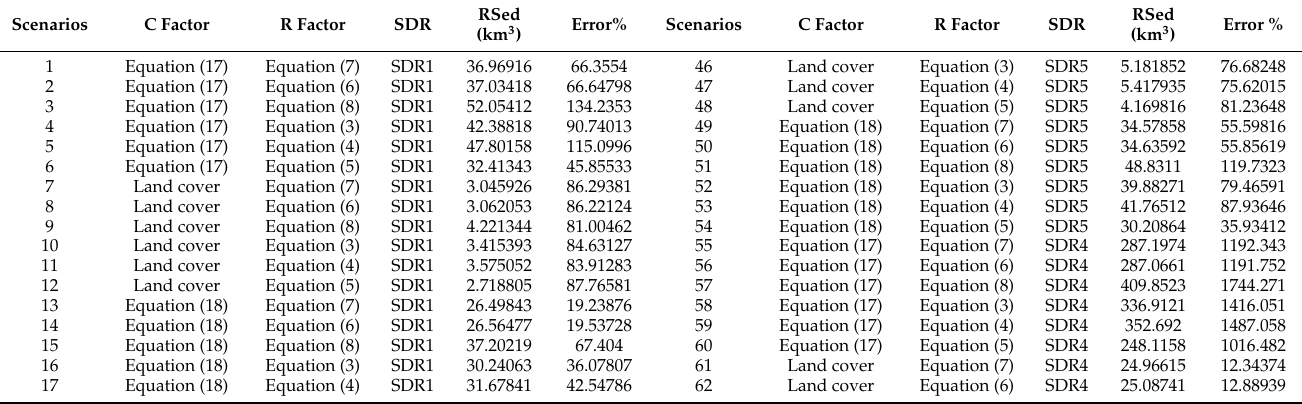
Table A3. The results of the scenarios examined in the Darbandikhan Lake for the period between November 1961 and 2 May